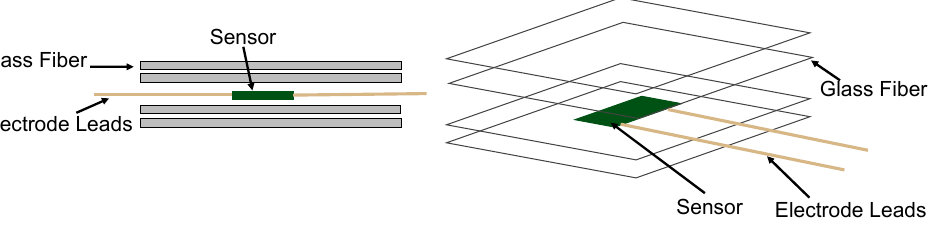
Figure 4. Schematics of the sensor embedment in the glass fiber composite.